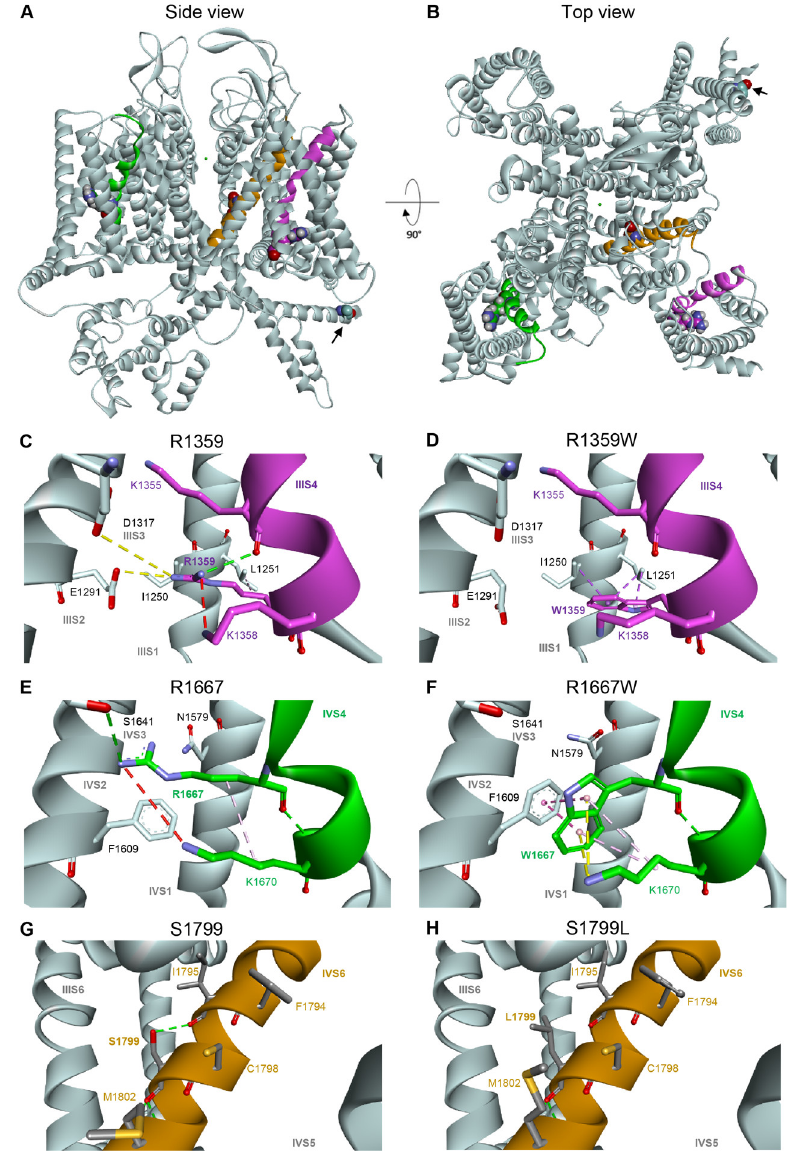
Figure 7. Homology model of human Cav2.1 viewed from the side ( A ) or from the top ( B ). The IIIS4, IVS4, and IVS6 transmembrane helices carrying the studied mutation are represented in magenta, dark green, and brown, respectively. The four residues R1359 (IIIS4), R1667 (IVS4), S1799L (IVS6), and A405 (I-II loop, indicated with black arrow) are represented in balls. ( C , D ) Modeling of the voltage sensing domain (VSD) in repeat III of WT Cav2.1 ( C ), and Cav2.1 R1359W ( D ), showing putative non-bonded interactions in dash lines: hydrogen bond pairs in green (K1355 in IIIS4), ionic bond pairs in yellow (E1291 in IIIS2, and to a lesser extent, D1317 in IIIS3), hydrophobic interaction in purple (L1251 in IIIS1). Steric clashes (K1358 in IIIS4) are represented by a red dashed line. ( E , F ) Modeling of the IV-VSD of WT Cav2.1 ( E ), and Cav2.1 R1667W ( F ). ( G , H ) Modeling of the pore domain around the IVS6 helix of WT Cav2.1 ( G ), and Cav2.1 S1799L ( H ).